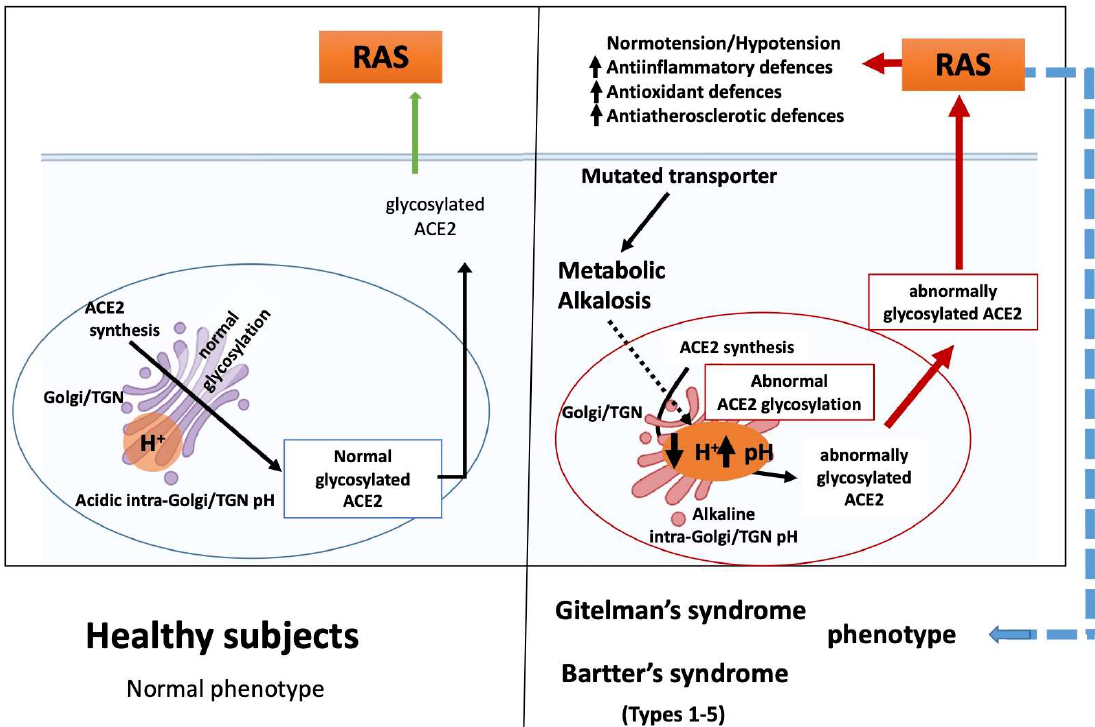
Figure 2. ACE2 protein glycosylation in a healthy subject and altered ACE2 protein glycosylation in GS/BS driven by changes in the pH of the TGN/endosome system with resulting effects on RAS.